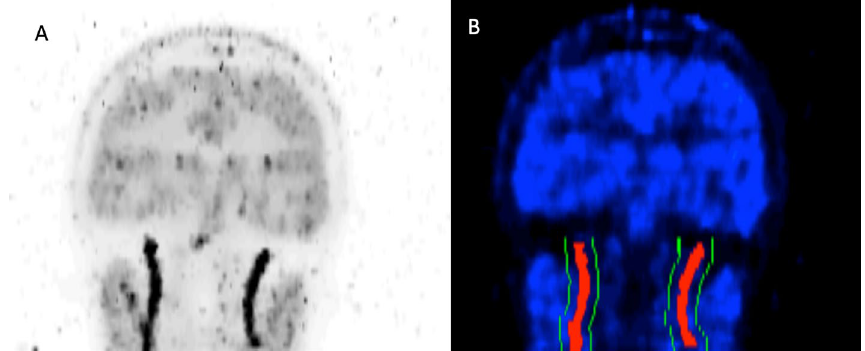
Fig. 2 Example subject maximum intensity projection over the entire dynamic scan ( A ) and binary carotid mask (red) and surrounding tissue mask (green) overlayed onto a single frame of a dynamic 15 O–water PET scan ( B